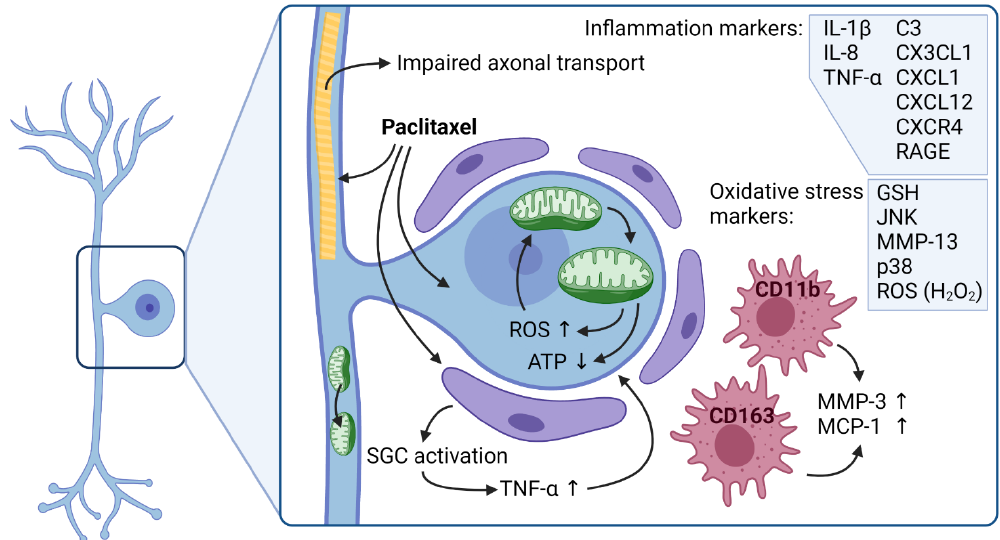
Figure 2. Pathomechanisms of paclitaxel-induced peripheral neuropathy in the peripheral nervous system. ATP — adenosine triphosphate, C3 — complement component 3, CD11b — cluster of differentiation 11B, CD163 — cluster of differentiation 163, CX3CL1 — C-X3-C motif ligand 1, CXCL1 — C-X-C motif chemokine ligand 1, CXCL12 — C-X-C motif chemokine ligand 12, CXCR4 — as C-X-C chemokine receptor type 4, GSH — glutathione, IL — interleukin, JNK — c-Jun N-terminal kinase, MCP-1 — monocyte chemoattractant protein 1, MMP — matrix-metalloproteinase, RAGE — receptor for advanced glycation end products, ROS — reactive oxygen species, SGC — satellite glial cell, TNF- α— tumor necrosis factor; Created with BioRender.com (accessed on 20 September 2021).